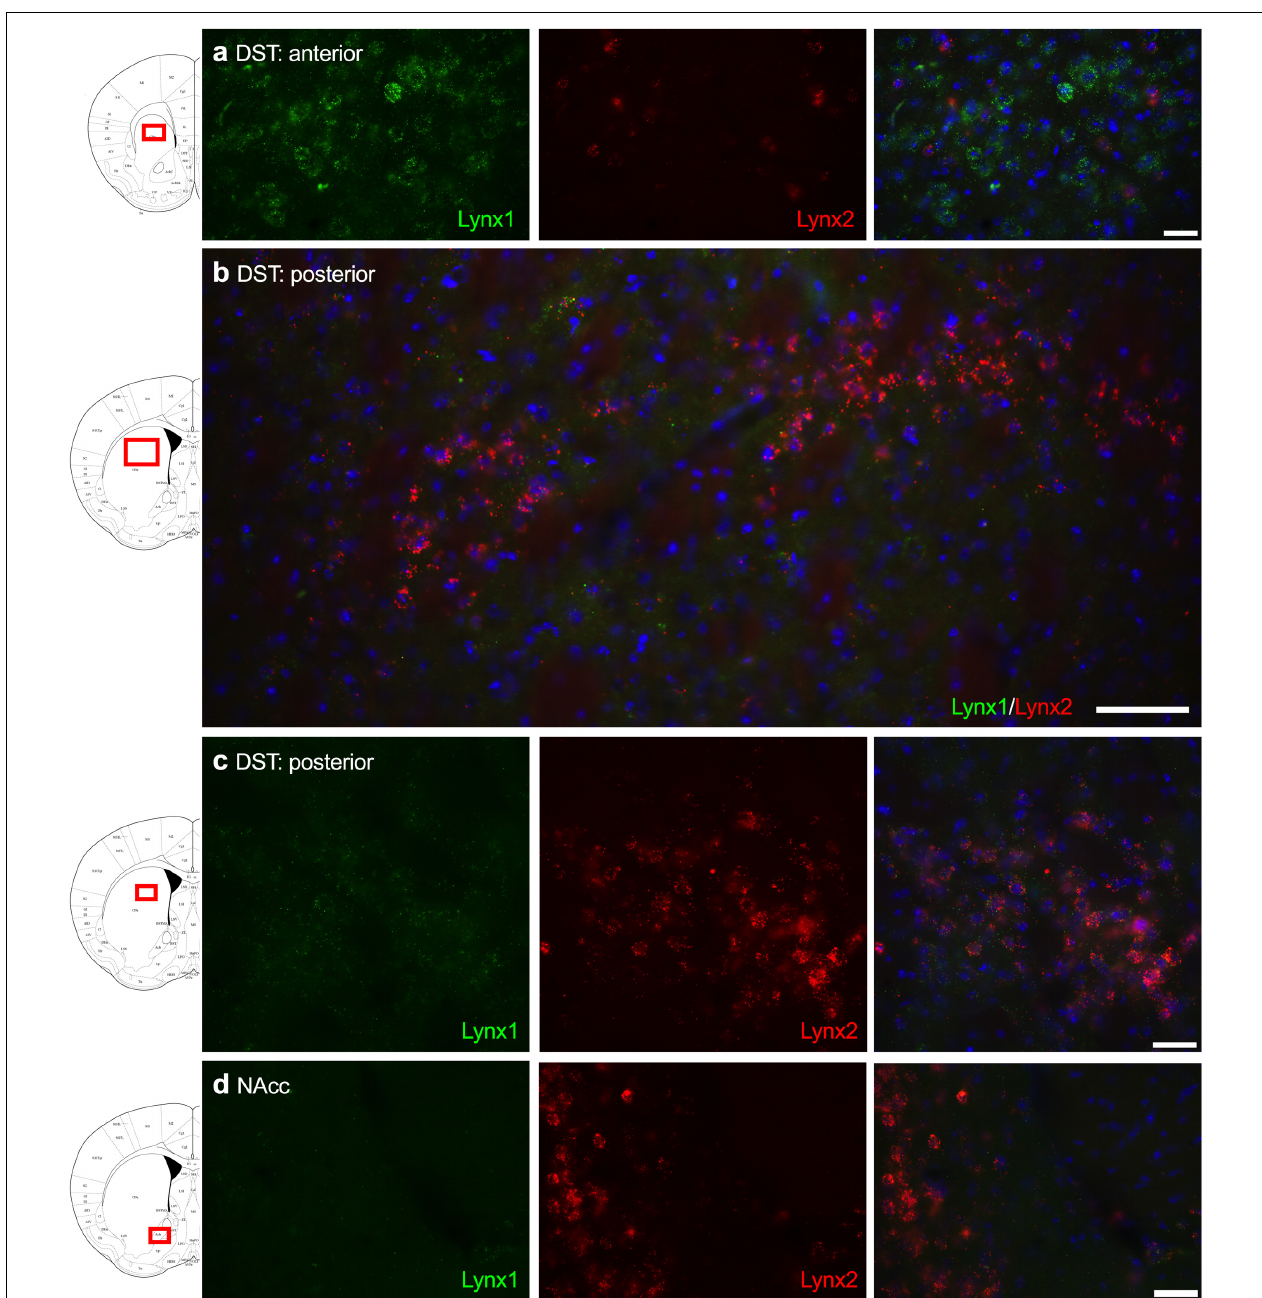
FIGURE 2 | Expression of lynx1 and lynx2 mRNA in the striatum. (a) High levels of lynx1 (green) were found in anterior dorsal striatum (DST), with lower levels of lynx2 (red). (b) Lower magnification of the posterior DST region shows clustered cells expressing lynx2. (c) Higher magnification of the posterior DST further illustrates dense expression of lynx2 in a cluster region. (d) In the nucleus accumbens (NAcc), preferential expression of lynx2 was observed. The red boxes on the brain plates to the left of each row illustrate the region shown in the respective microscopy images. Blue: DAPI. Scale bar for (a,c,d) 40 µ m. Scale bar for (b) 100 µ m.